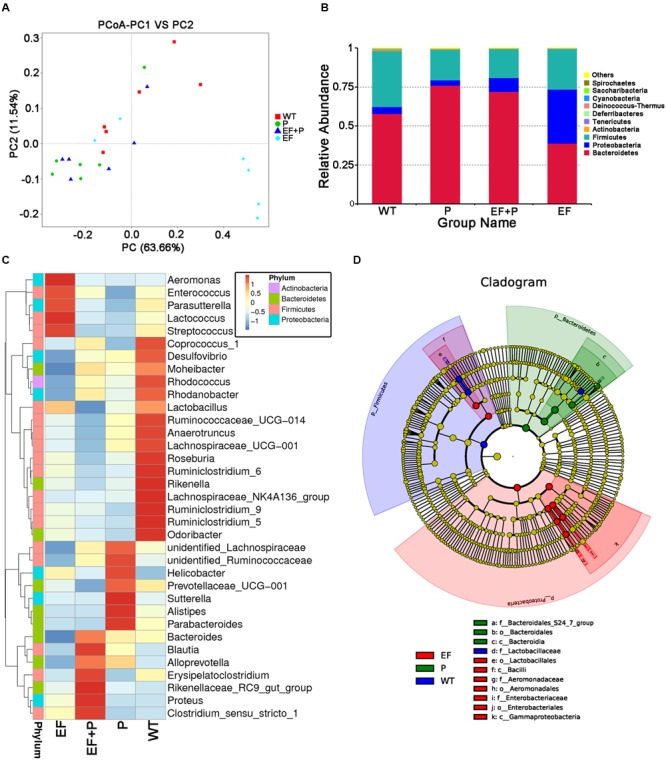
The effects of E. faecalis challenge and phage therapy on the composition of the gut microbiota. The composition of the gut microbiota in the feces of challenged and normal mice that were treated with or without phage EF-P29 was analyzed using 16S rRNA gene sequencing (n = 6 for each group). (A) A plot was generated using the weighted version of the UniFrac-based PCoA. (B) Bacterial taxonomic profiling at the phylum level of intestinal bacteria identified in different mouse groups. (C) Heatmapping shows that the abundance of intestinal bacteria at the genus level was significantly altered by treatment with phage EF-P29 in challenged and normal mice. (D) The cladogram demonstrates the phylogenetic distribution of microbial lineages in fecal samples obtained from differently treated mice.